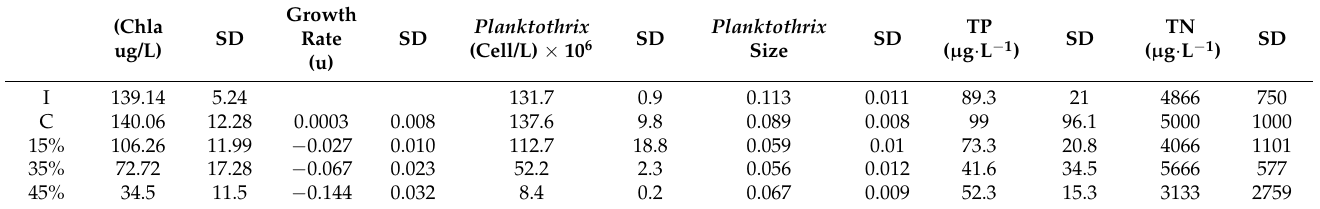
Table A2. Phytoplankton biomass, growth rate, Planktothrix density, and Planktothrix size in the Control (C) and the 15%, 35%, and 45% PVI treatments after 10 days.